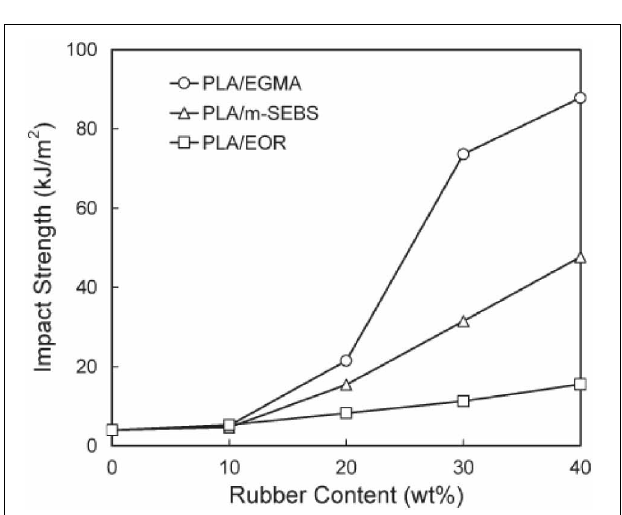
FIGURE 25 | Impact strength of PLA blends as function of rubber content. Copyright (2012) Wiley; used with permission from Jiang et al.